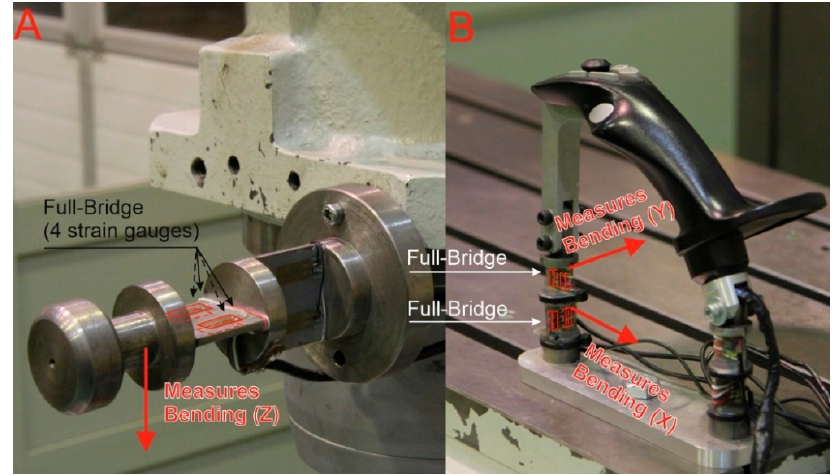
Figure 4. Distribution of strain gauges and neckings: ( A ) Auxiliary lever; ( B ) main lever.